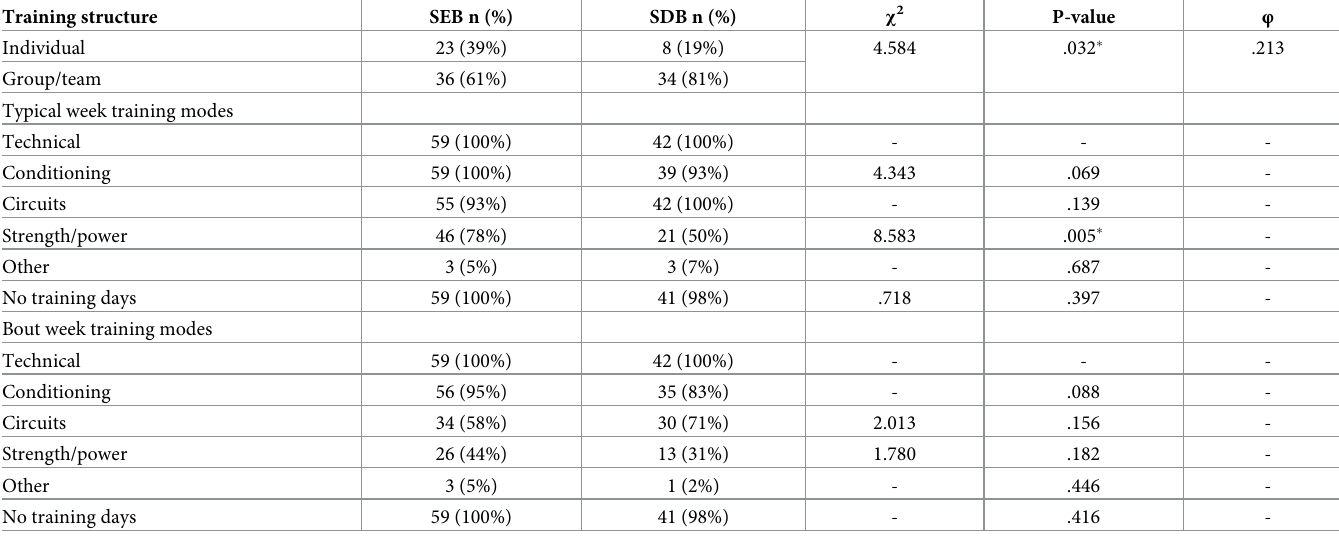
Table 2 comprises data on the association of the perceived importance of physical attri- butes, and competitor level. Descriptive data was also included for comparisons between groups. Half of all boxers (50%) selected aerobic fitness as the most important physical quality to boxing performance, the most popular choice in both groups. Table 1. Training structure and modes during a typical week and bout